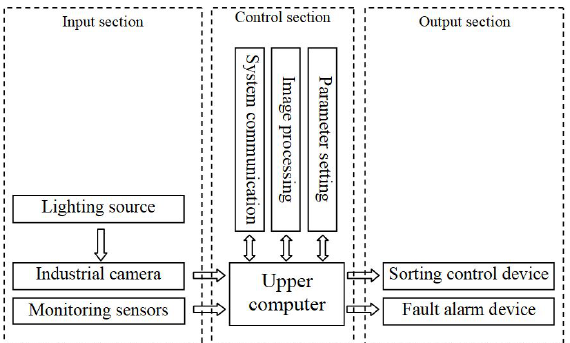
Fig. 2. The block diagram of the